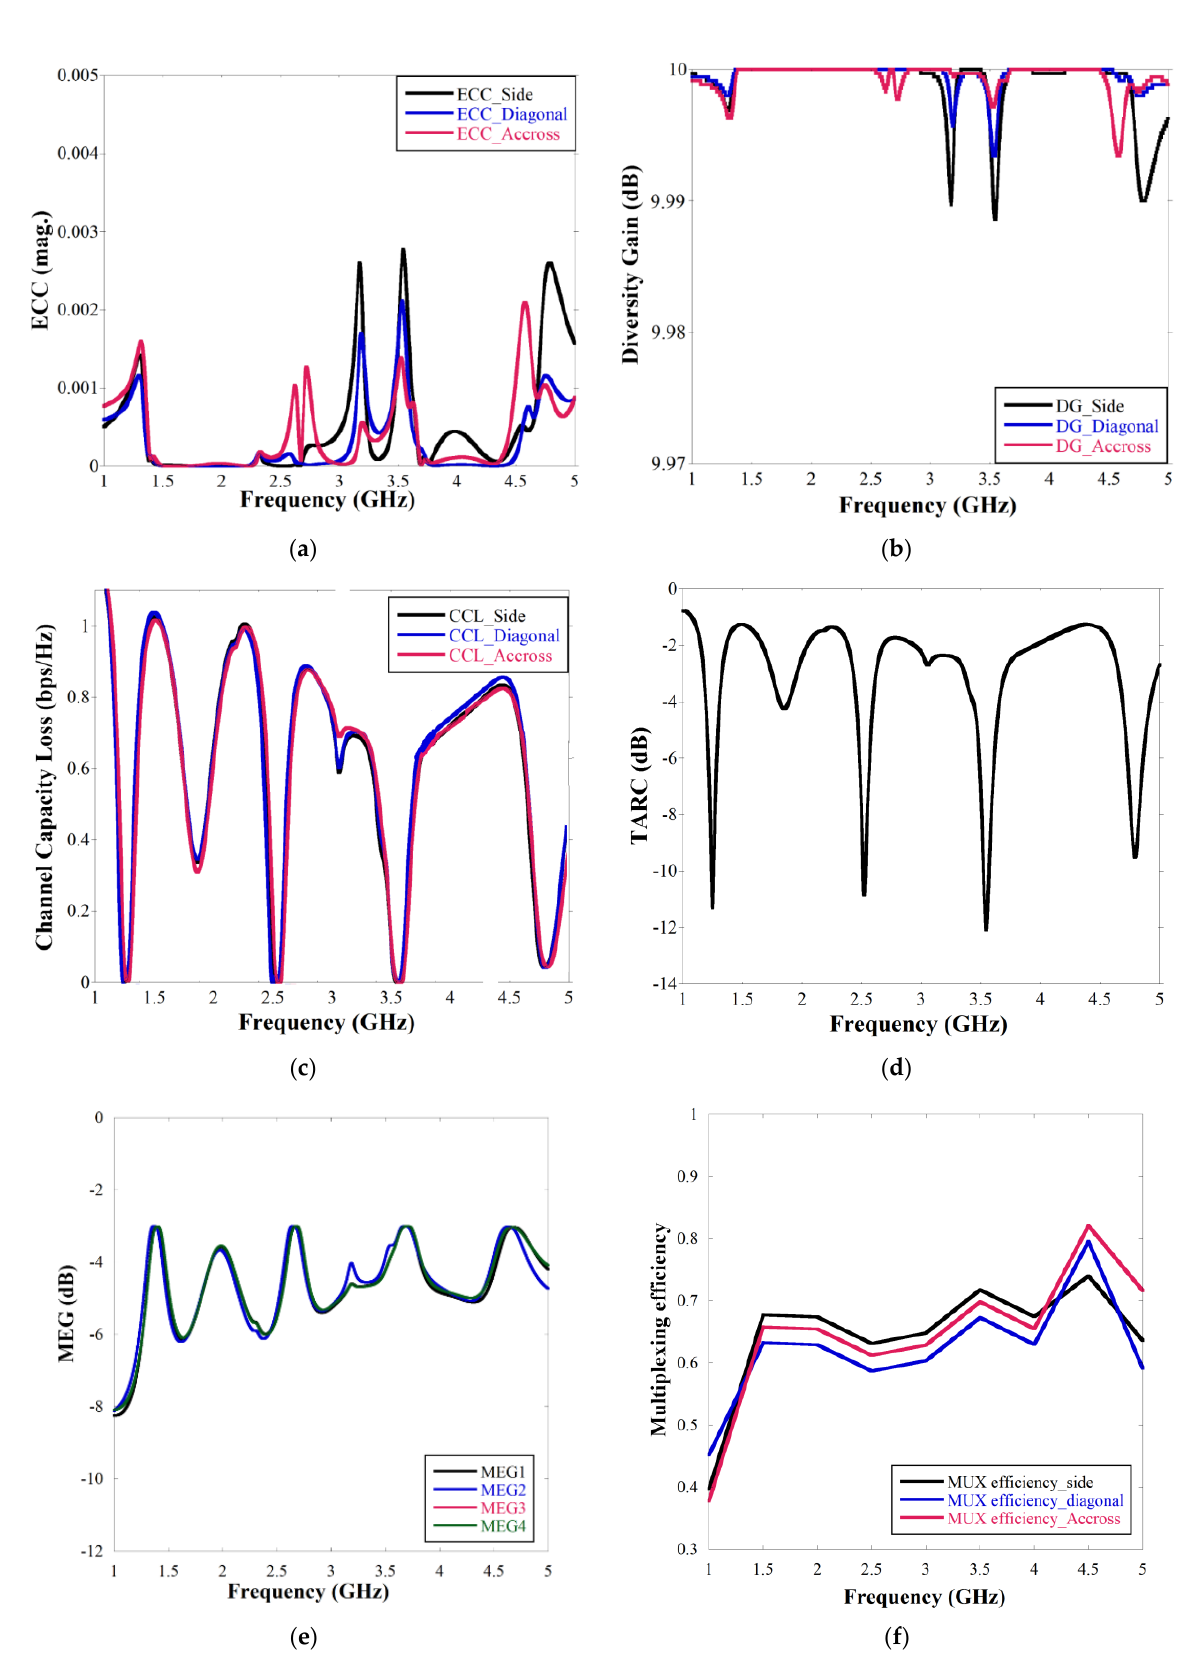
Figure 9. Diversity performances of quad elements quadband MIMO antenna ( a ) ECC, ( b ) diversity gain, ( c ) CCL, ( d ) TARC, ( e ) MEG, ( f ) multiplexing efficiency plot. gain, ( c ) CCL, ( d ) TARC, ( e ) MEG, ( f ) multiplexing efficiency